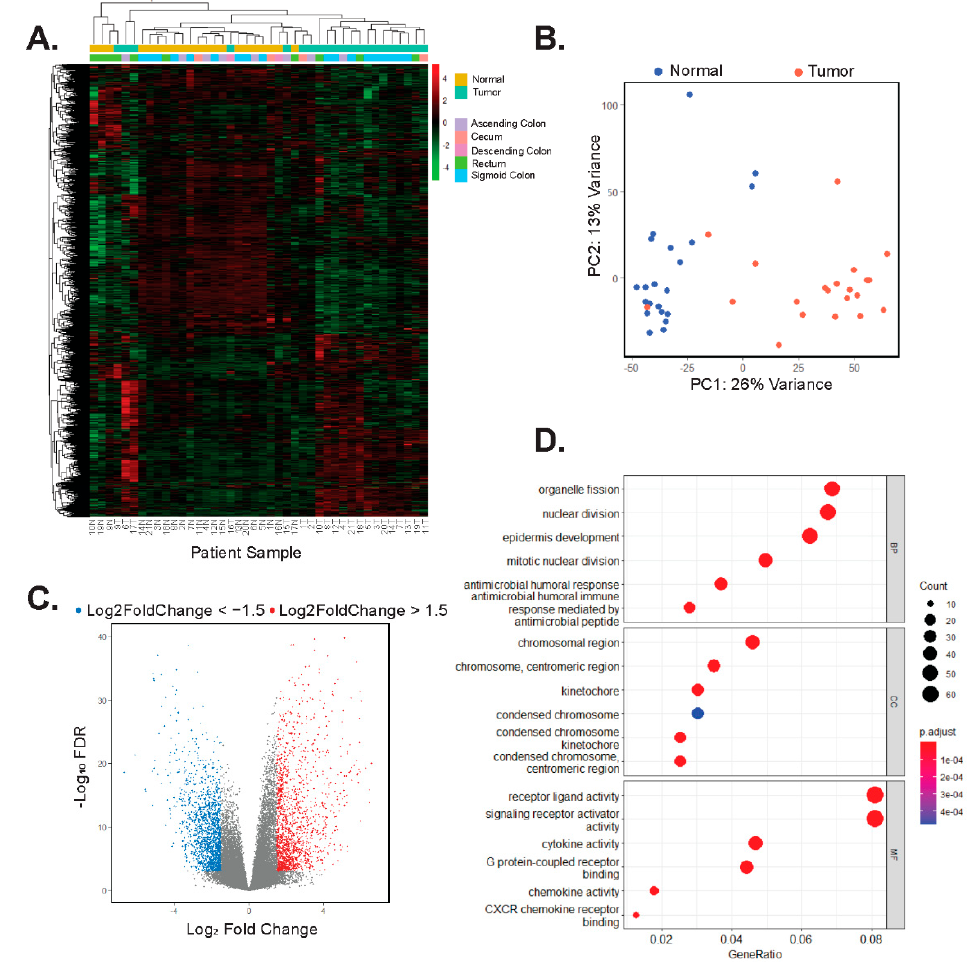
Figure 1. Tumors and adjacent colonic segments display distinct transcriptomic profiles. ( A ) Heatmap and hierarchical clustering of rlog normalized gene expression of the top 4000 most variable genes in tumors and adjacent control tissues. Patients are arbitrarily assigned 1–21 and N represents uninvolved tissues, whereas T represents tumor. ( B ) Principal component analysis (PCA) of the top 4000 most variable genes expressed in uninvolved (normal) and tumors. ( C ) Volcano plot of differentially expressed genes in tumors versus uninvolved control colonic tissues. Red points are 1521 genes whose expression is significantly upregulated (log2Foldchange > 1.5, p -adj < 0.05) and blue points are 1542 genes whose expression is significantly down-regulated (log2Foldchange < − 1.5, p -adj < 0.05) in tumors versus controls. ( D ) GO analysis on the 1521 genes whose expression is upregulated in tumor samples. The top six results in each of the categories, biology processes (BP), cellular component (CC), and molecular function (MF) are shown in descending order.